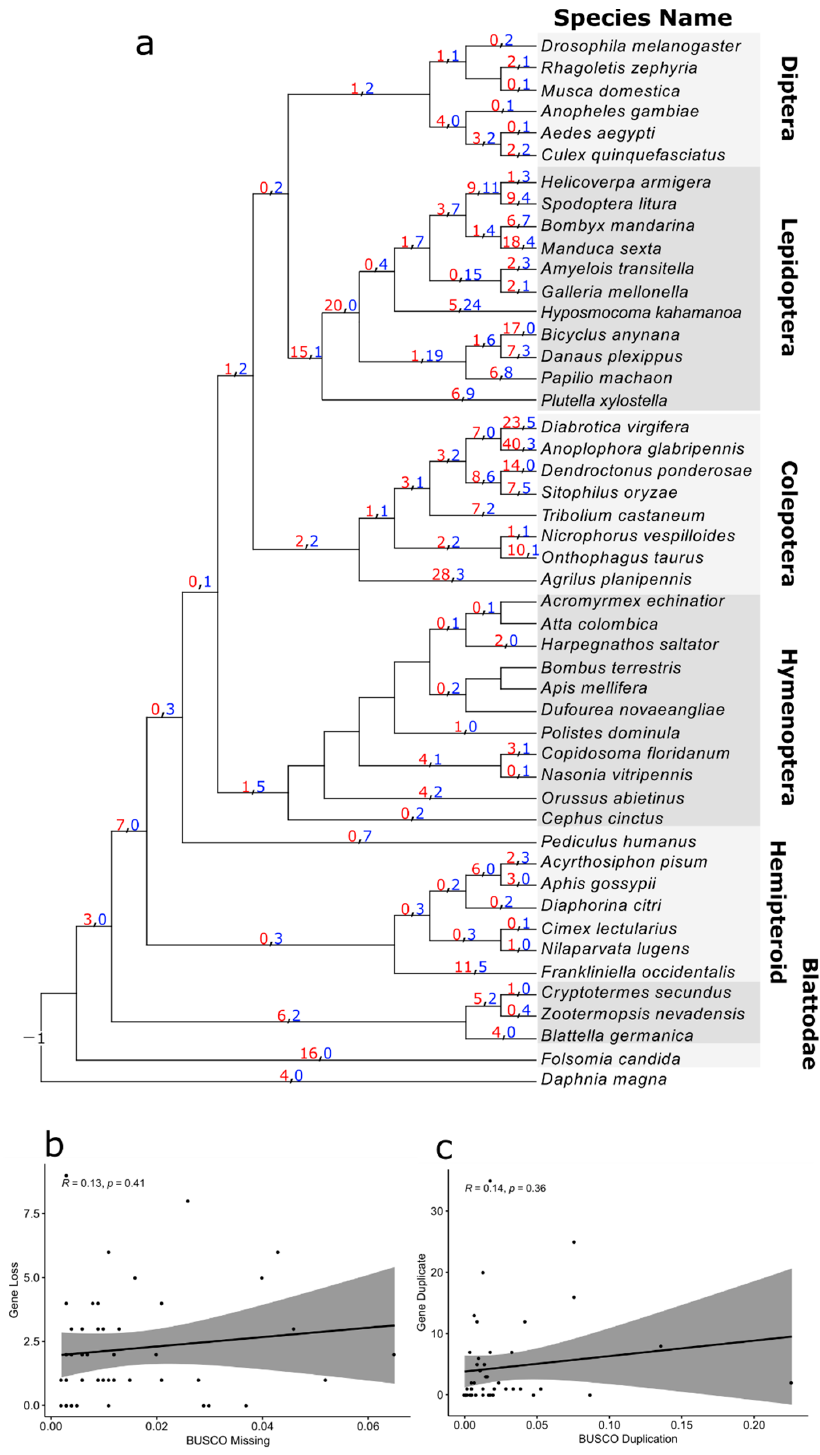
Figure 5. Duplication and loss inference via the reconciliation of the GH1 gene tree with a species tree: ( a ) the species tree was inferred from a few previous studies as described in the Methods section. Numbers in red indicate duplications, and numbers in blue indicate losses; ( b ) the correlation between inferred gene losses of terminal branches and BUSCO missing scores of the species at the corresponding tips; ( c ) the correlation between inferred gene duplications of terminal branches and BUSCO duplication scores of the species at the corresponding tips.